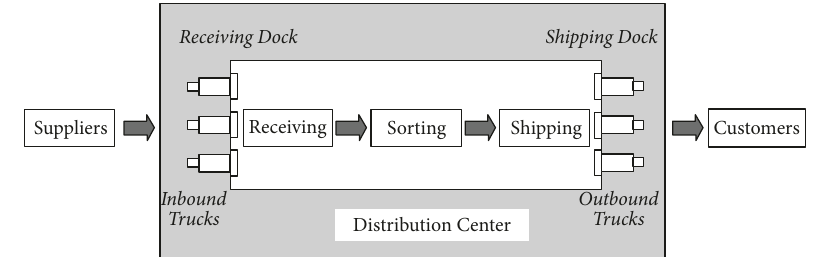
Figure 1: General cross-docking operation